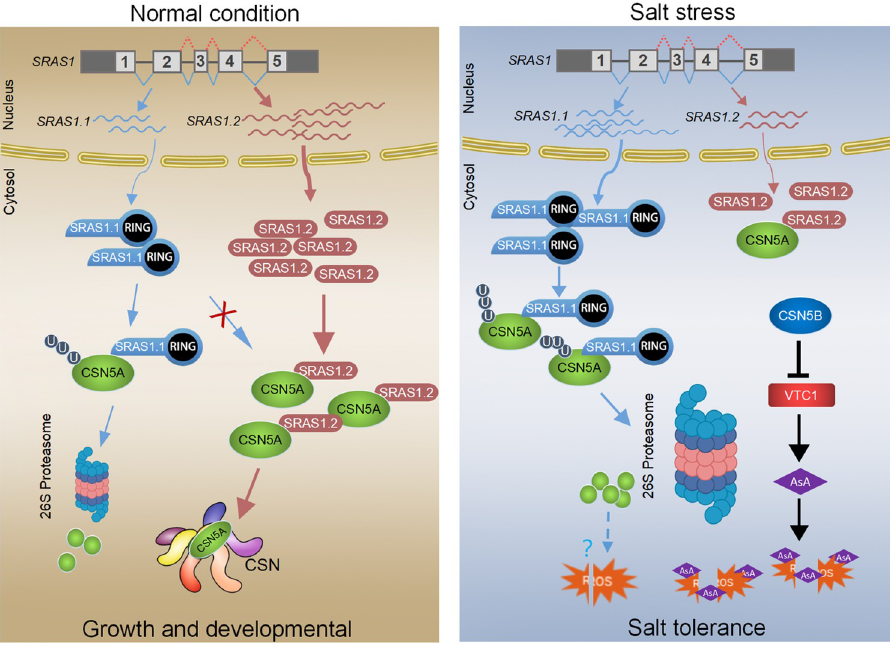
Fig 8. A regulatory model of salt responsive AS event on a E3 ligase SRAS1. The SRAS1 could produce two splicing variants, encoding SRAS1.1 and SRAS1.2, respectively. The full-length SRAS1.1 protein has E3 ubiquitin ligase activity while the truncated SRAS1.2 lacks E3 ligase activity. Under normal conditions, SRAS1 undergoes AS event to produce a high level of SRAS1.2 which interacts with and protects CSN5A. CSN5A is more stable, and incorporated into the CSN complex regulating plant growth and development. Salt stress that triggers splicing events affects the ratio of SRAS1.1/SRAS1.2, and SRAS1.1 promotes CSN5A degradation by 26S proteasome to control ROS accumulation. Simultaneously, CSN5B, which plays the predominant role, interacts with VTC1 in regulating ascorbic acid (AsA) synthesis to enhance salt